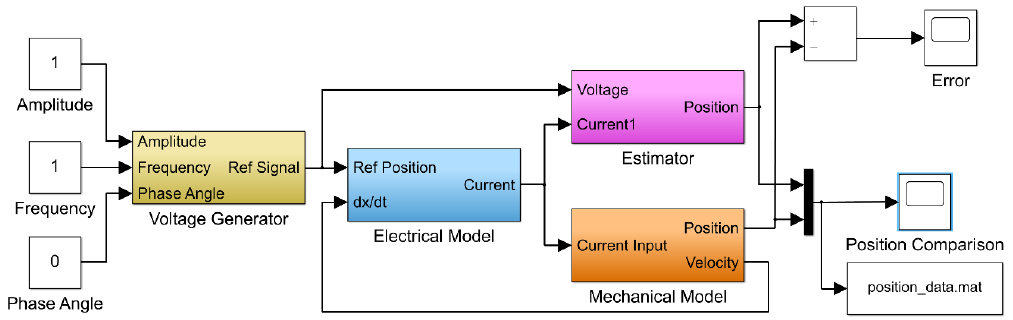
Figure 3. Simulink model for the position estimator algorithm.